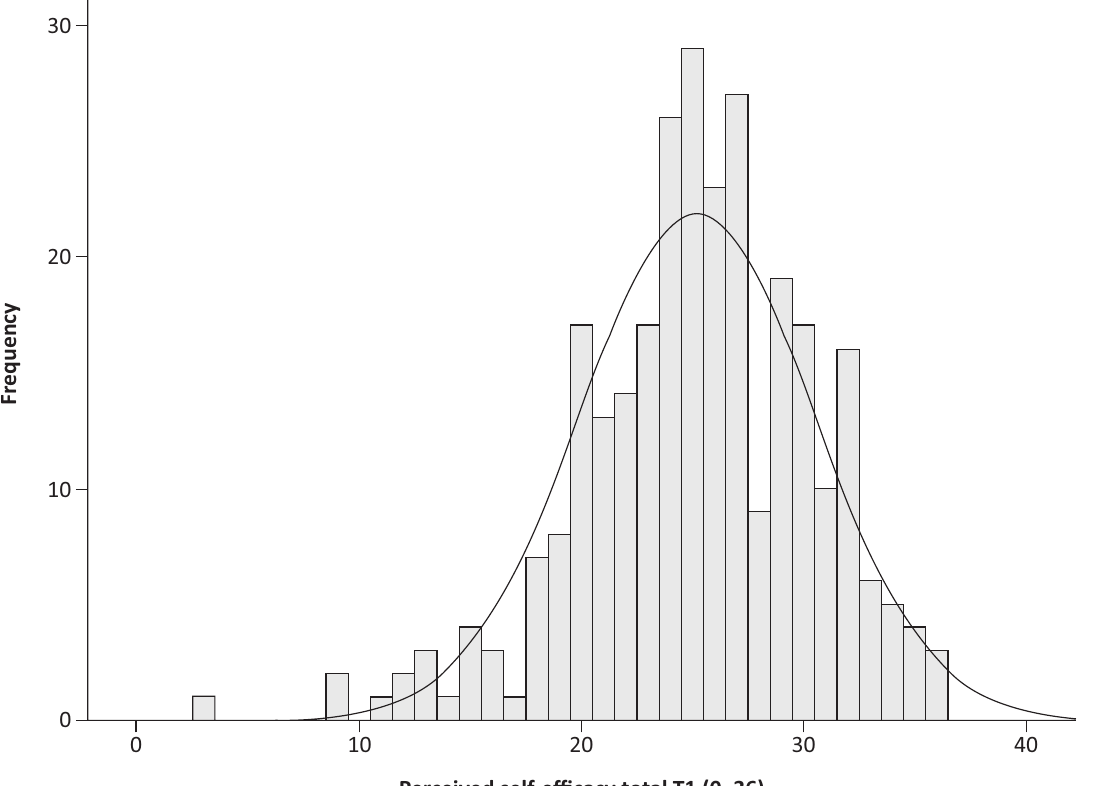
Figure 1. Perceived self-efficacy total at T1. dard deviation of 3.986 (Table 2). The range of the self- esteem scores was 22, with a minimum score of 8 and a maximum of 30. Self-esteem scores between 15 and 25 are considered “normal”. The data showed that 11 young people had a score under 15 (representing low scores), while 53 young people had a score above 25 (representing high scores). The skewness of the self- esteem scores was − 0.333 (very small left skew) and the kurtosis was 0.491 (normal mesokurtic). Using addi- tional testing with P-P Plots, Q-Q Plots, and One-Sample Kolmogorov-Smirnov Test (p > 0.05), it could be said that the scores for self-esteem were normally distributed (Fig- ure 2). These results refute hypothesis 2 which states that participants have low